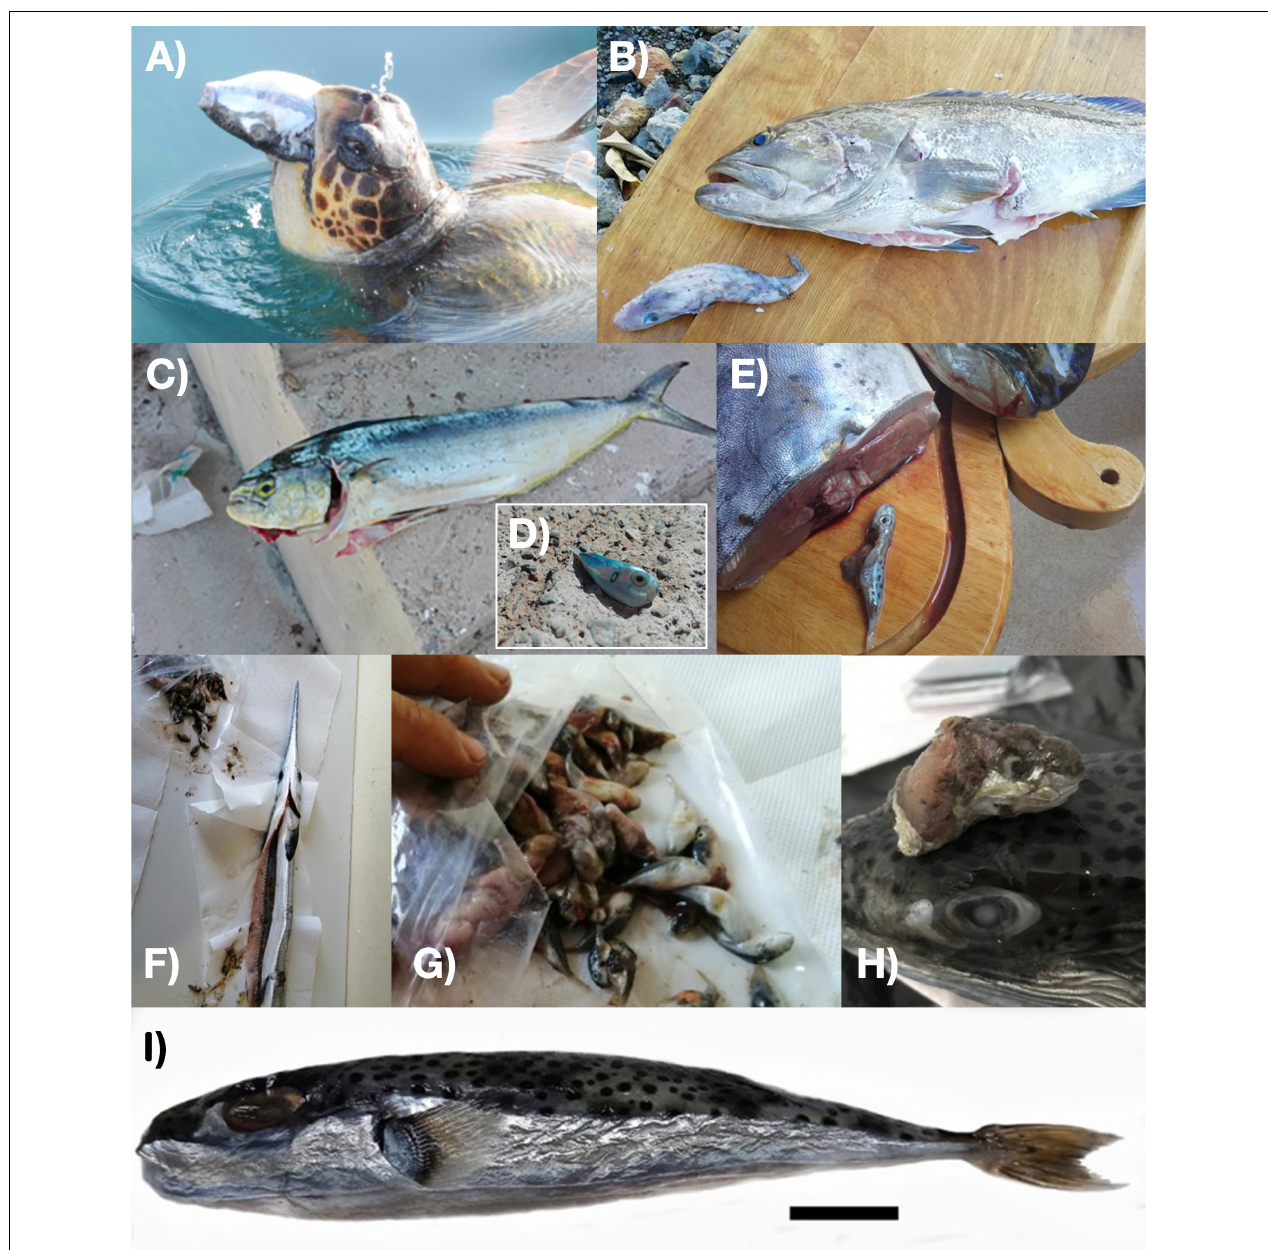
FIGURE 2 | Photographs evidencing predation on invasive Lagocephalus sceleratus in the Mediterranean Sea (details in Table 2 ): (A) Caretta caretta; (B) Epinephelus aeneus ; (C,D) Coryphaena hippurus ; (E) Coryphaena hippurus ; (F,G) Belone belone with stomach full of juvenile L. sceleratus ; (H) cannibalism; (I) well preserved specimen from cannibalism (6.4 cm total